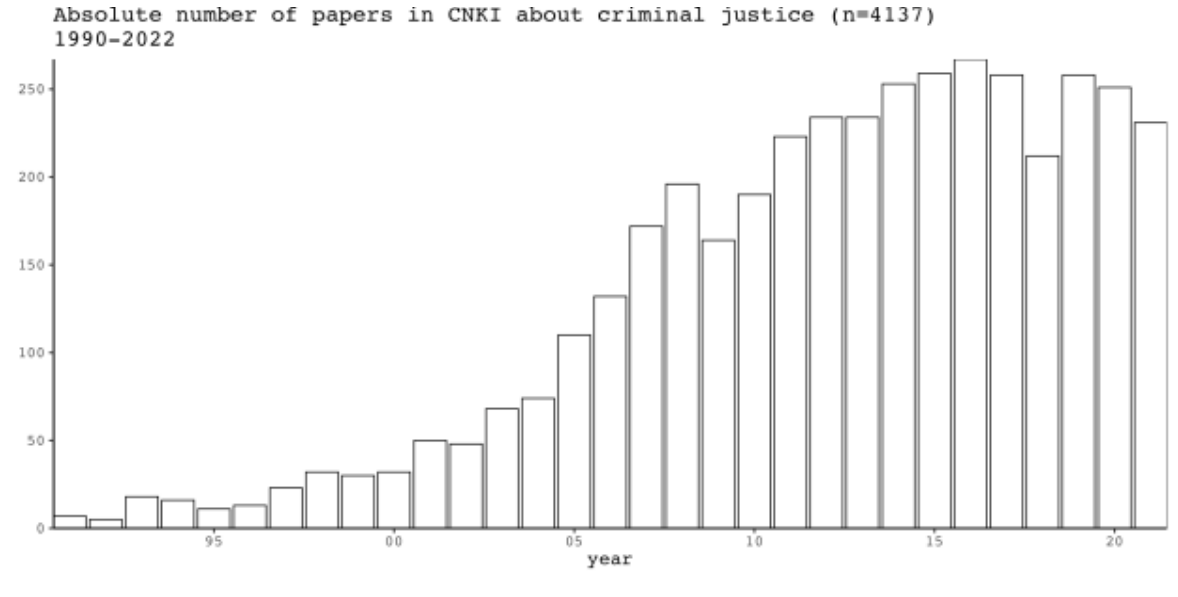
Figure 3: Number of scholarly papers containing the term criminal justice (1990–2022) Source: China National Knowledge Infrastructure